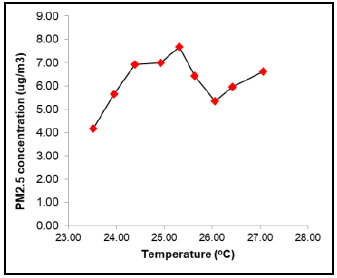
Figure 16. PM 2.5 concentration changes with the increase of temperature